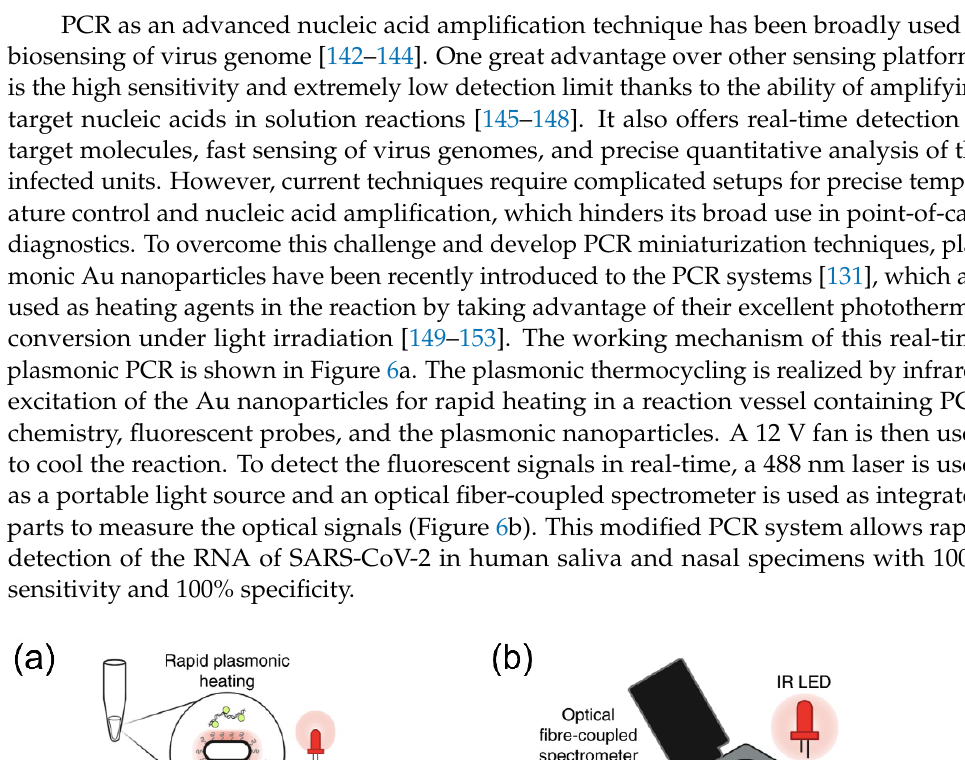
Figure 5. Responsive plasmonic nanostructures for biosensing. ( a ) SEM (top panel) and TEM (bot- tom panel) of the polypyrrole nanotubes decorated with Au nanoparticles. ( b ) Schematic illustration of the preparation and working principle of the biosensors for antibody detection. Reprinted from [141], with permission from Elsevier Ltd.